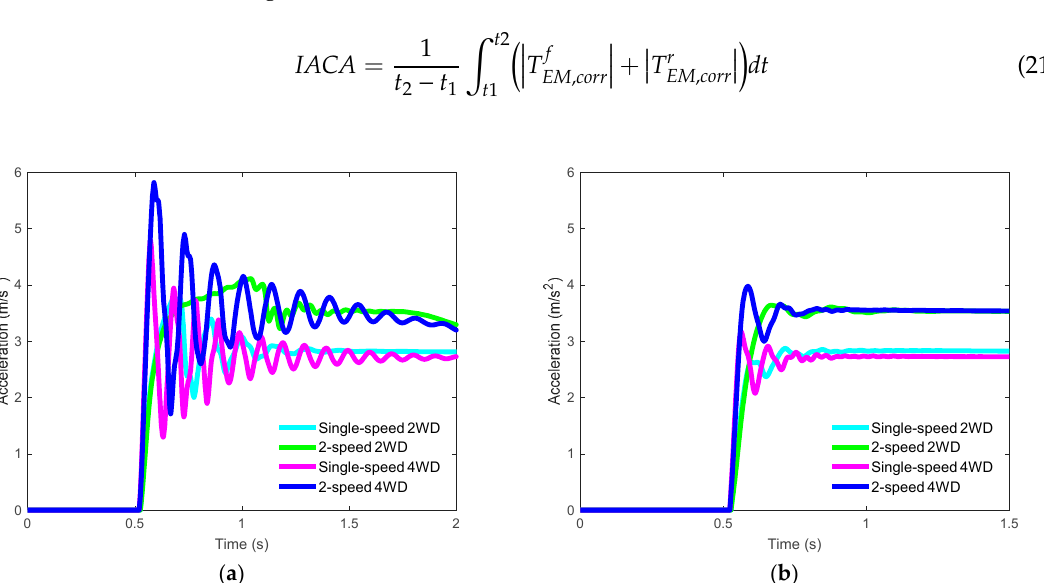
Figure 8. Longitudinal vehicle acceleration profiles for the four EV layouts, during a tip-in from an initial speed of 10 km/h: ( a ) Without anti-jerk controller; ( b ) With anti-jerk controller.